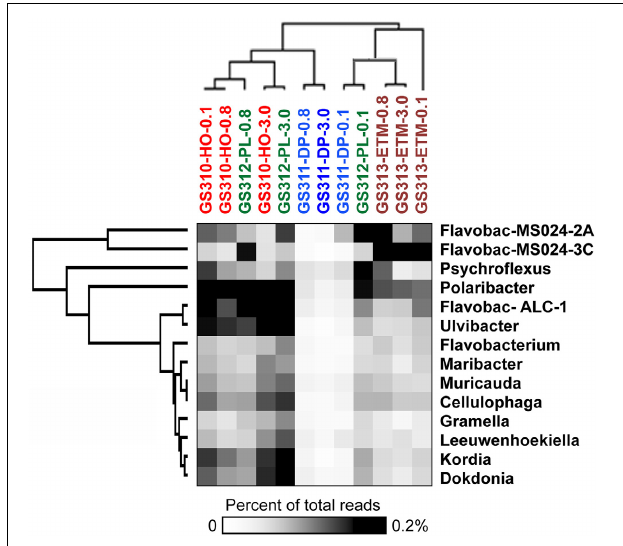
FIGURE 1 | 2D Hierarchical clustering (average linkage) of genera from bacterial family Flavobacteriaceae (Y-axis) in metagenomes (X-axis). For each genus, abundance was calculated as the percentage of all corresponding hits with > 90% identity to total annotated prokaryotic peptides in the corresponding metagenome. Abundance values are shaded from white to black on a scale indicating percentages from low to high. Sample names are composed of the GS (“global survey”) number of the JCVI sample data base and habitat: HO, shelf hypoxic water; DP, deep ocean bottom; PL, plume; ETM, estuarine turbidity maximum. The numbers above the sample names indicate size fractions: 0.1, 0.1–0.8 μ m;